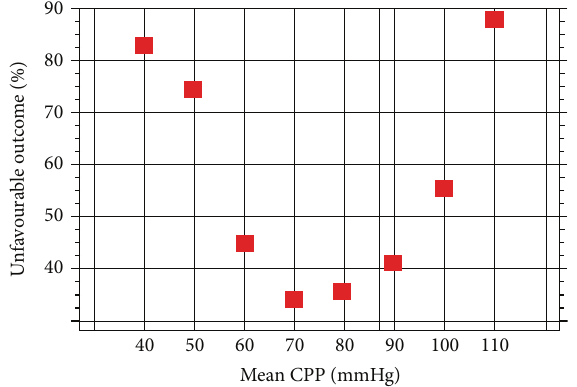
Figure 6: Mortality rate, expressed as a function of CPP, shows distinctive “U shape” curve. CPP: cerebral perfusion